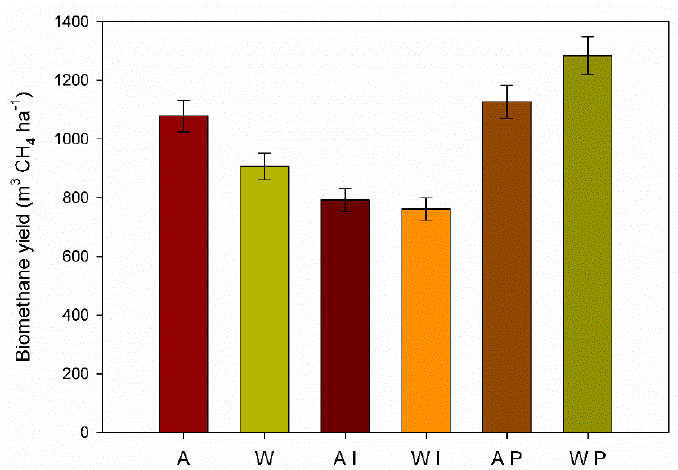
Figure 5. Biomethane yield (m 3 CH 4 ha − 1 ) of untreated GRB (autumn, A; winter, W), autumn and winter pretreated with I. lacteus (AI and WI, respectively), autumn and winter pretreated with P. ostreatus (AP and WP, respectively). Significant interaction (LSDint p ≤ 0.05) for BMY